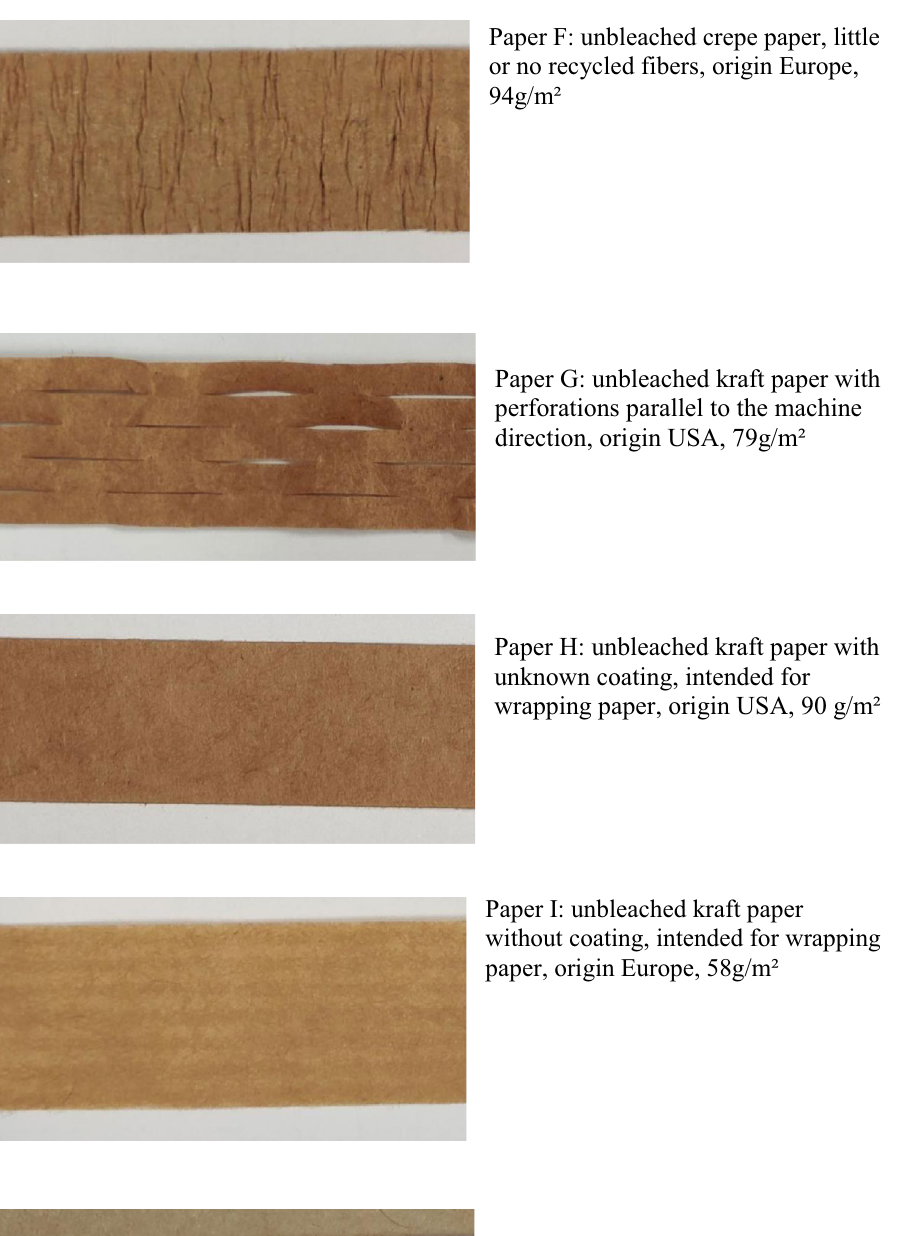
Paper P: randomly selected printing paper, composition not known,